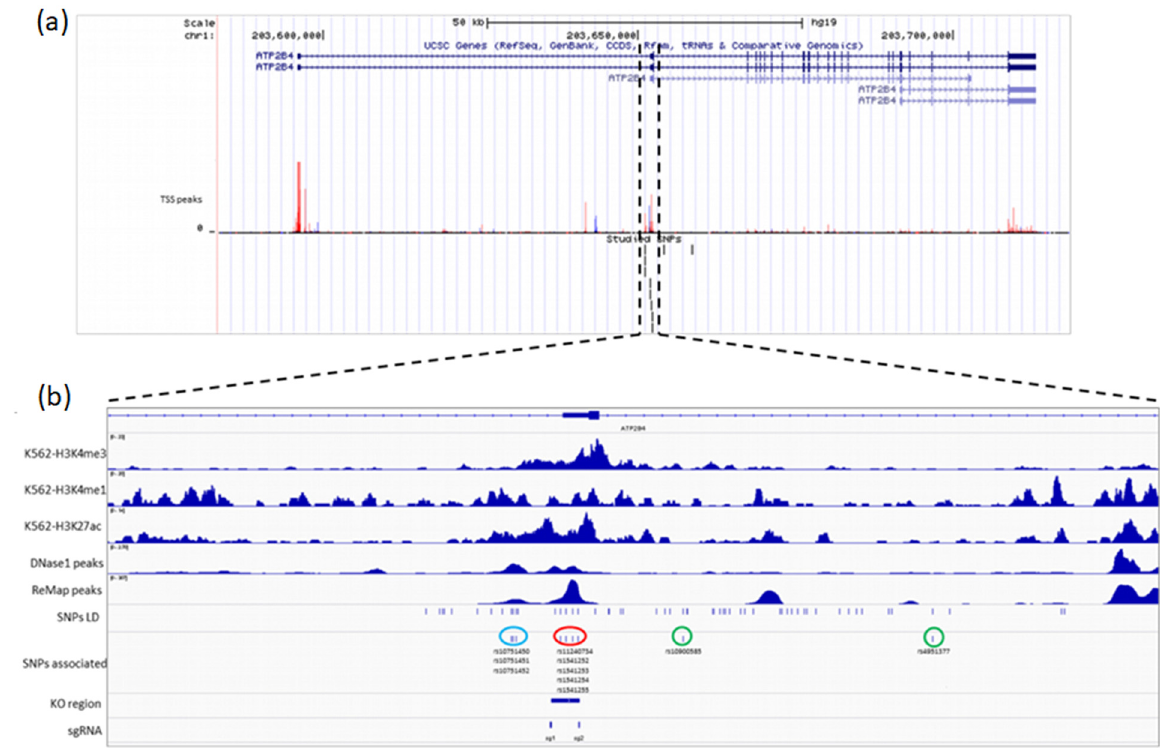
Figure 2. Visual representation of the ATP2B4 locus and the epigenomic marks of the region containing the five ATP2B4 candidate variants. ( a ) Transcripts, TSS peaks, and studied SNPs are displayed. The two long transcripts ( ATP2B4 -203 and ATP2B4 -204) and the short transcripts are displayed. The main TSS peaks are visualized. ( b ) The candidate SNPs (rs11240734, rs1541252, rs1541253, rs1541254, and rs1541255; encircled red) are on chromosome 1, located within a DNaseI hypersensitivity region and peaks of H3K4me3, H3K4me1, and H3K27ac histone marks. The two tagSNPs (rs10900585 and rs4951377; encircled green) are located neither in peaks of ChIP-seq in the ReMap catalog nor in other epigenomic marks. The three additional regulatory variants (rs10751450, rs10751451, and rs10751452; encircled blue), previously identified as functional SNPs, are displayed.